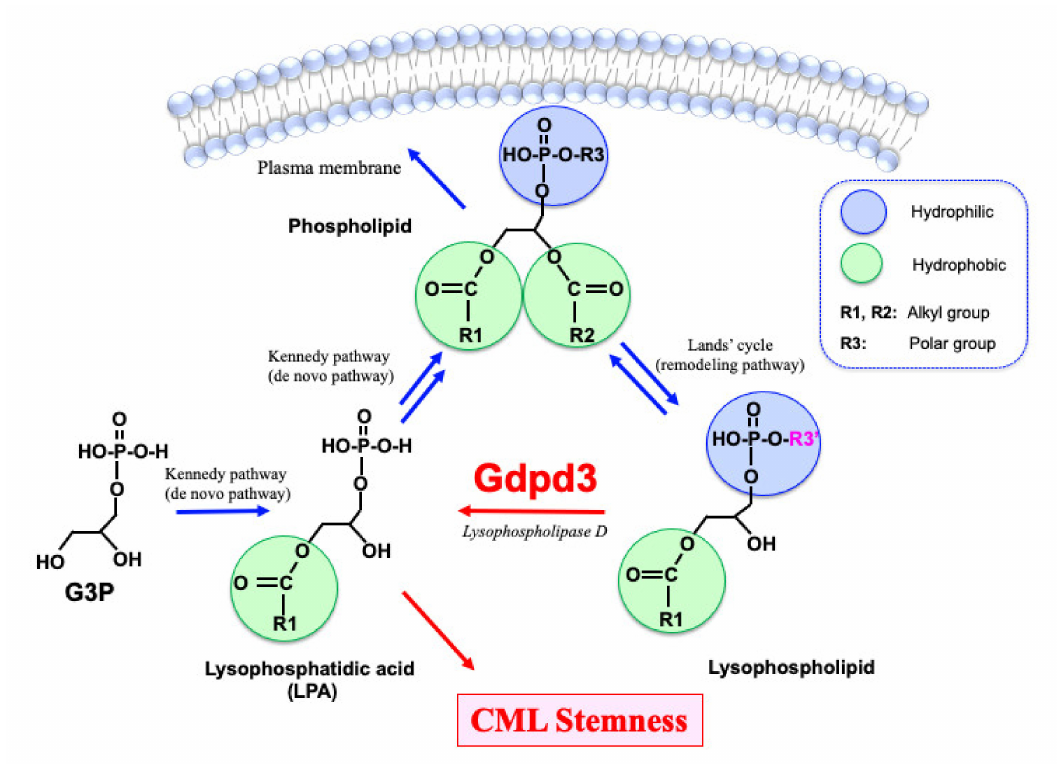
Figure 1. Lipid metabolism in CML stem cells. Glycerophospholipids (phospholipids), which organize the lipid bilayer in a cell’s plasma membrane, are synthesized from lysophosphatidic acids (LPAs). LPAs originate from glycerol 3-phosphate (G3P) via the Kennedy pathway (de novo pathway). Phospholipids are converted to lysophospholipids via the Lands’ cycle (remodeling pathway), which can reverse to produce a wide variety of phospholipids. Lysophospholipids are recycled back into LPAs by lysophospholipase D enzymes such as Gdpd3. Whereas phospholipids have two hydrophobic fatty acid chains, lysophospholipids and LPAs have only one fatty acid chain. Thus, lysophospholipids and LPAs are more hydrophilic than phospholipids and can act as lipid second messengers. We recently demonstrated that CML stemness in vivo depends on Gdpd3 and its function in lysophospholipid metabolism